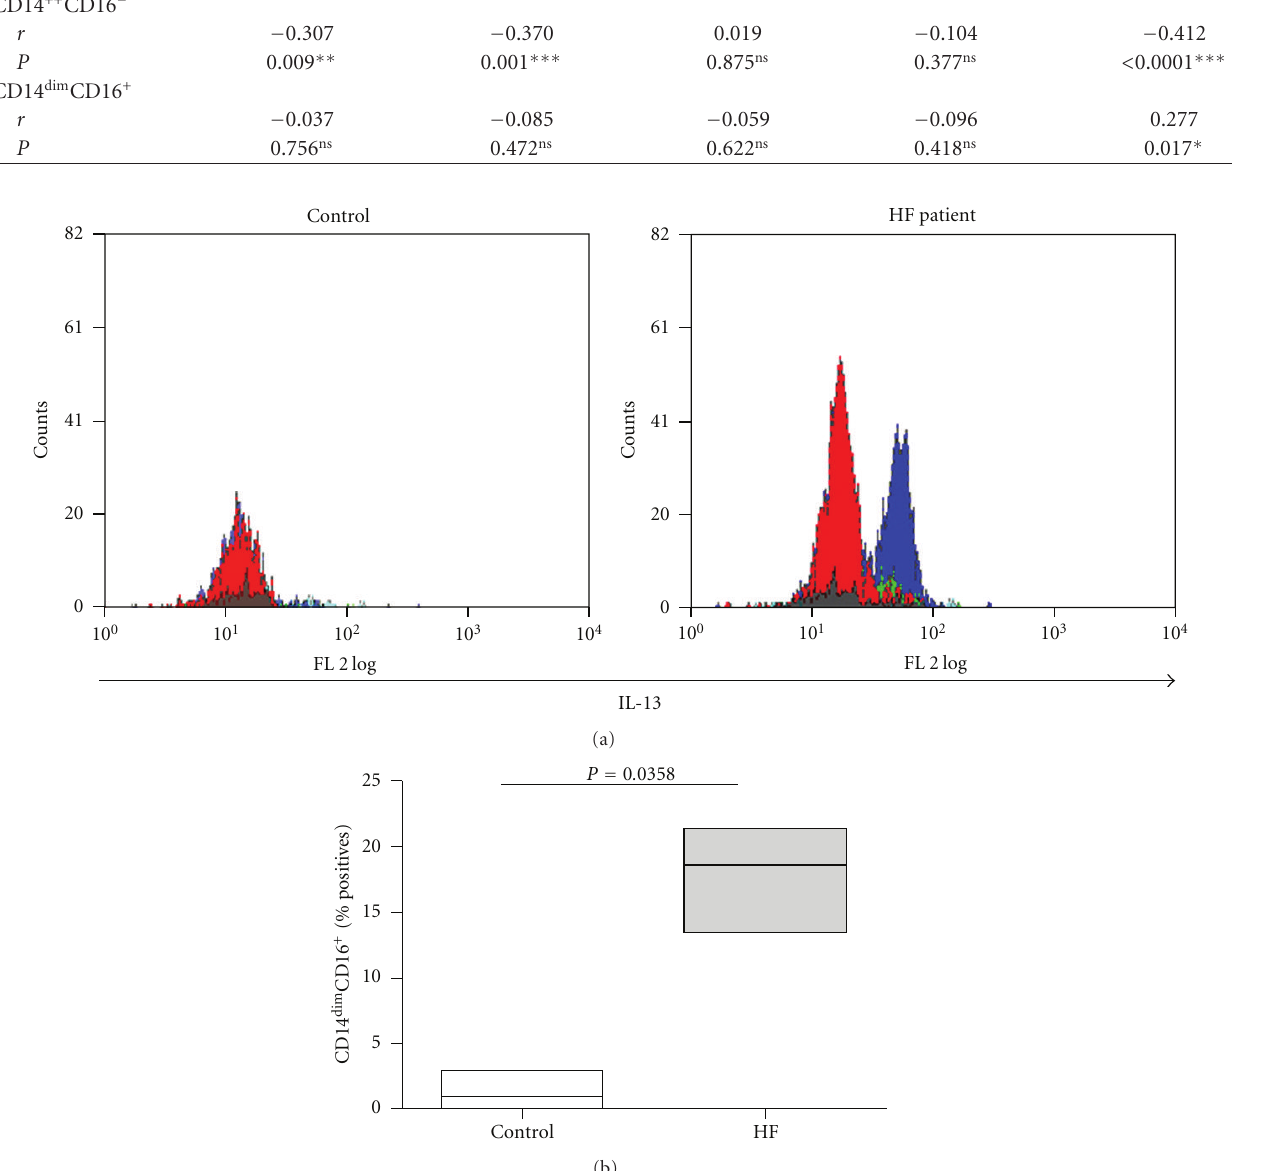
Figure 2: Production of IL-13 by each of the monocyte subsets. (a) Representative flow cytometry histograms of IL-13 producing monocyte subsets in a healthy control and an HF patient. Each of the three monocytes subsets was gated as described in Figure 1, and their respective ability to express IL-13 was evaluated by intracellular staining for the cytokine ( n = 5). Grey histogram, isotype control for IL-13; red histogram, the CD14 ++ CD16 − classical subset; green histogram, the CD14 + CD16 + subset; blue histogram, the CD14 dim CD16 + nonclassical subset. (b) Their percentage (median values) from the CD14 dim CD16 + monocytes was determined.